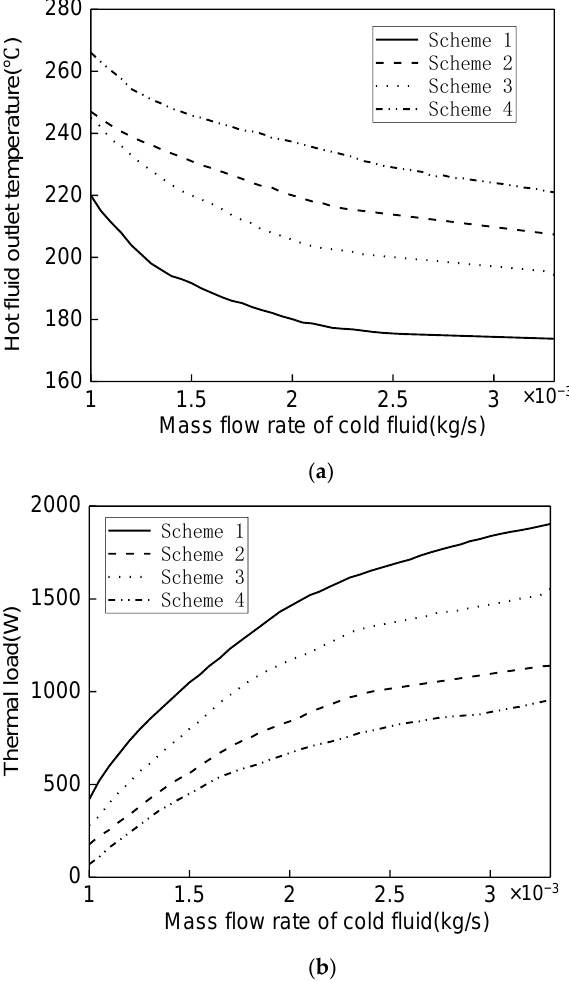
Figure 4. Comparison of the thermodynamic characteristics of the four convective heat transfer schemes (( a ) fluid temperature distribution; ( b ) thermal load).